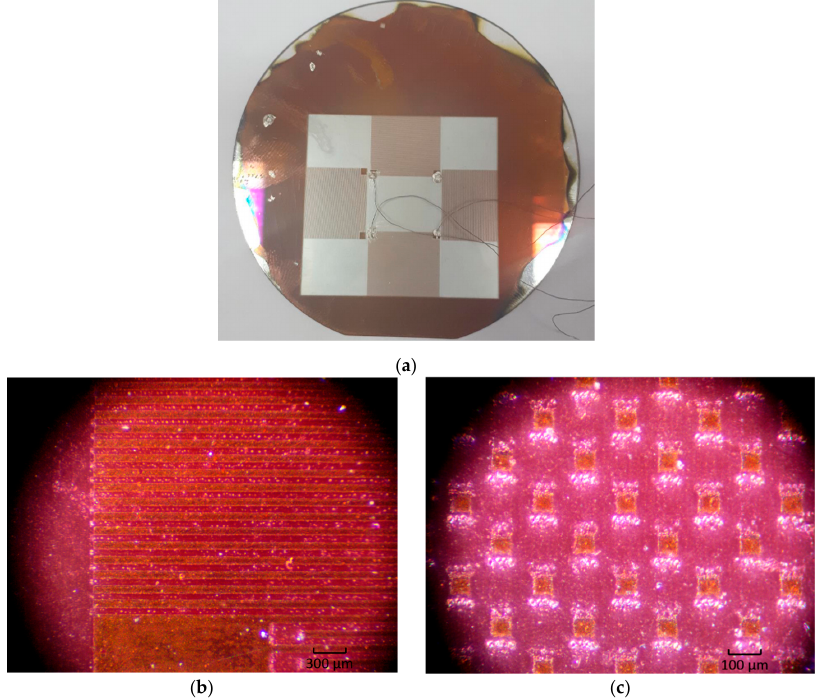
Figure 5. Prototype of the sensitive element of a SAW-based solid-state gyroscope under a microscope: ( а ) general view; ( b ) IDT and reflectors; ( c ) inertial mass matrix.